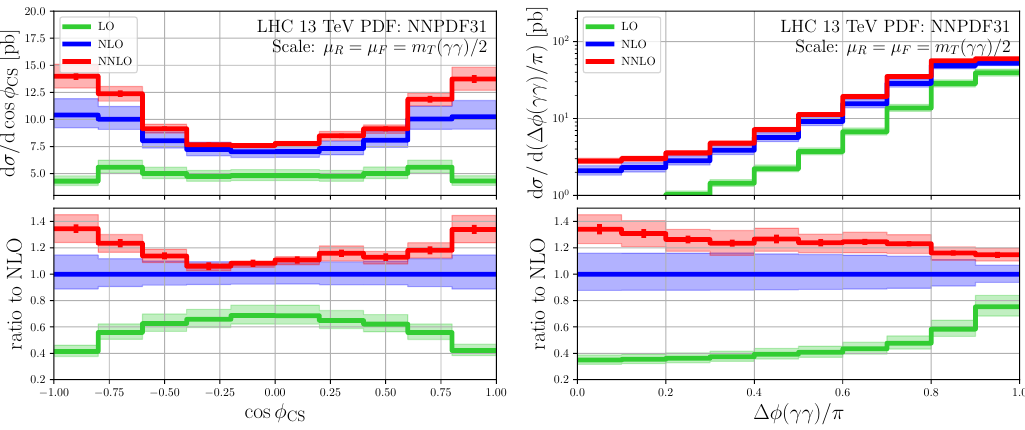
Figure 3 . As in figure 1 but for the angular distributions in φ CS (left) and ∆ φ ( γγ ) (right).